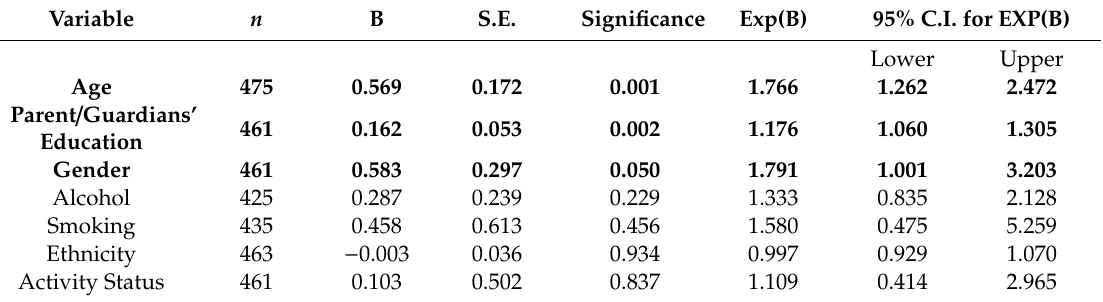
Table 2. Logistic regression analysis of independent predictors of dietary supplement